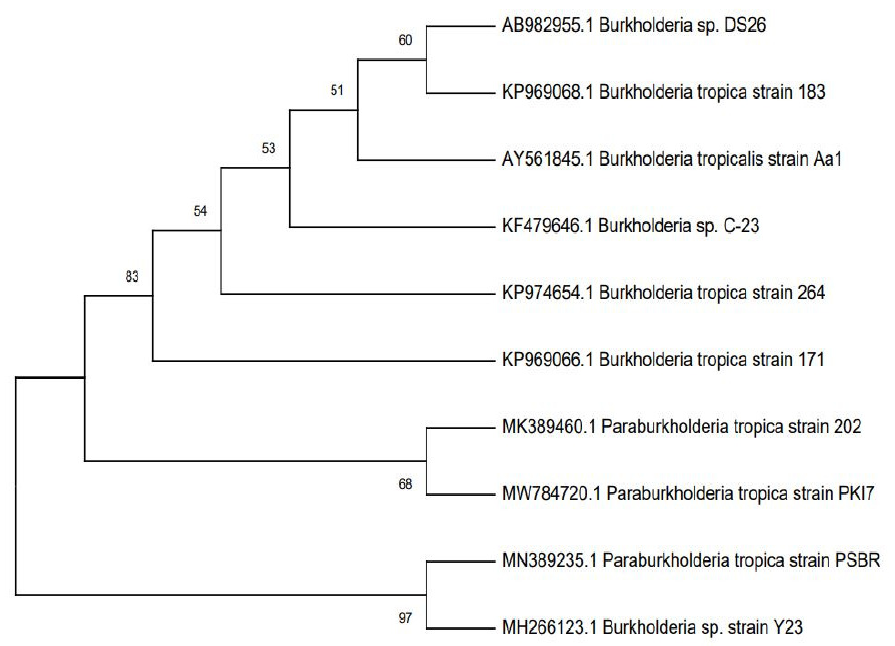
Figure 6. Phylogenetic tree (Neighbor-Joining consensus tree) on the basis of 16S rRNA sequence of gene showing the distance between strain PKI7 with other strain of Paraburkholderia species. The numbers over branches represent bootstrap confidence values (%) based on 1000 replicates. The Genbank accessions are shown in parenthesis